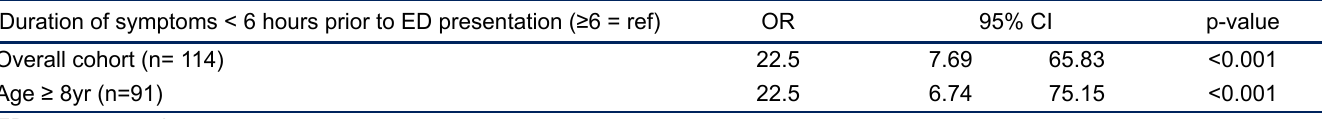
Table 3. Multivariate analysis predicting orchidopexy in the overall cohort and in patients ≥ 8 years